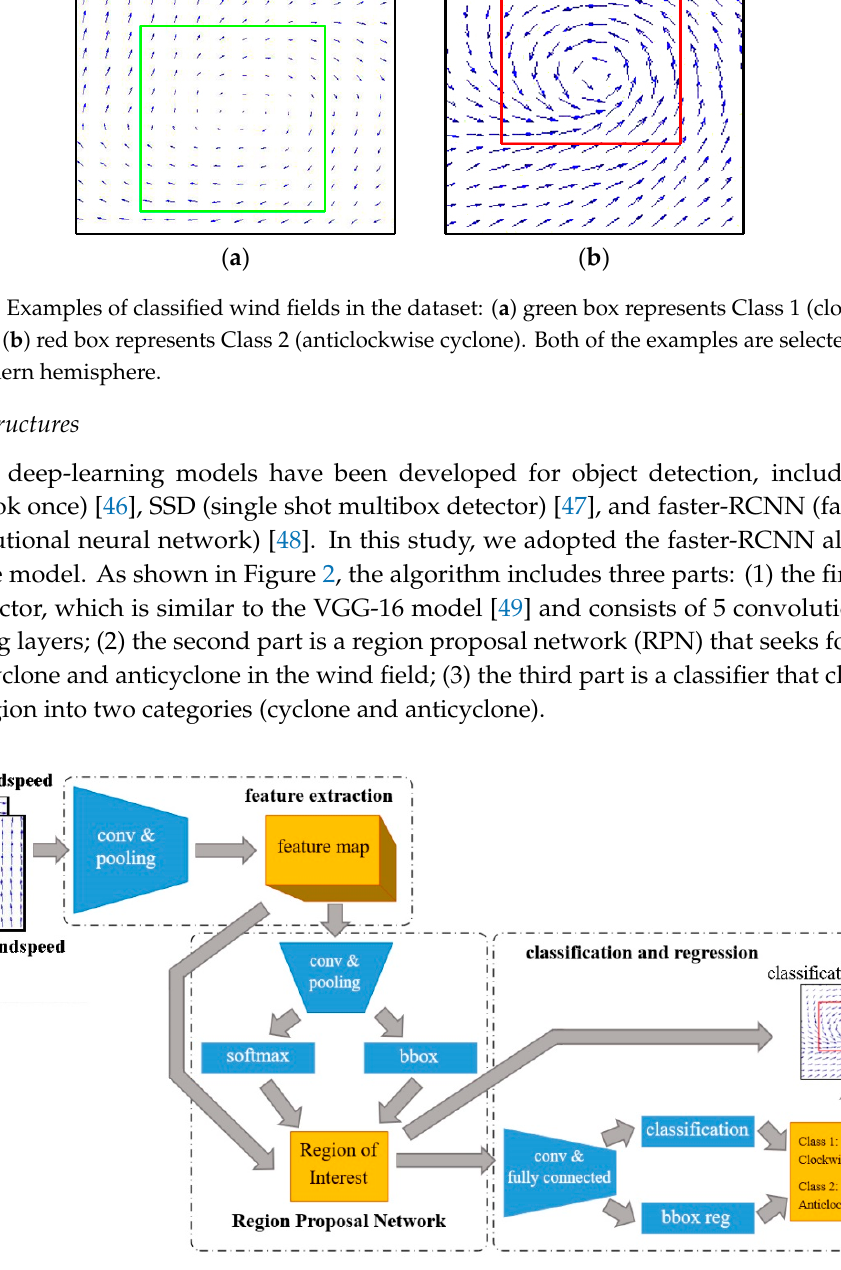
Figure 2. Flowchart of cyclone/anticyclone detection algorithm.